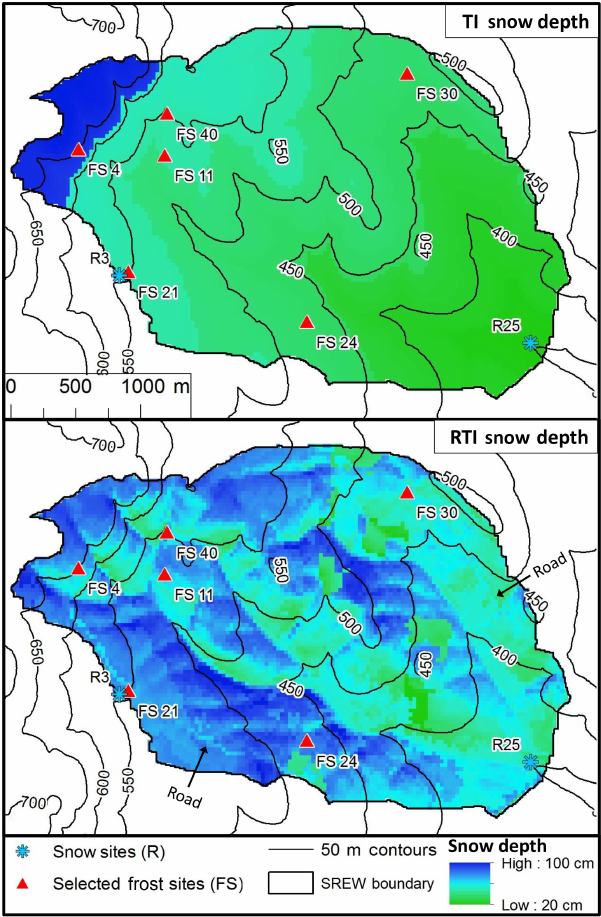
Figure 2. Simulated maps of snow depth (TI and RTI models) within the W-3 watershed for 23 February 2007. No observed maps of snow depth are available, but the map shows the differences be- tween the temperature-based (TI) model and the modified (RTI)